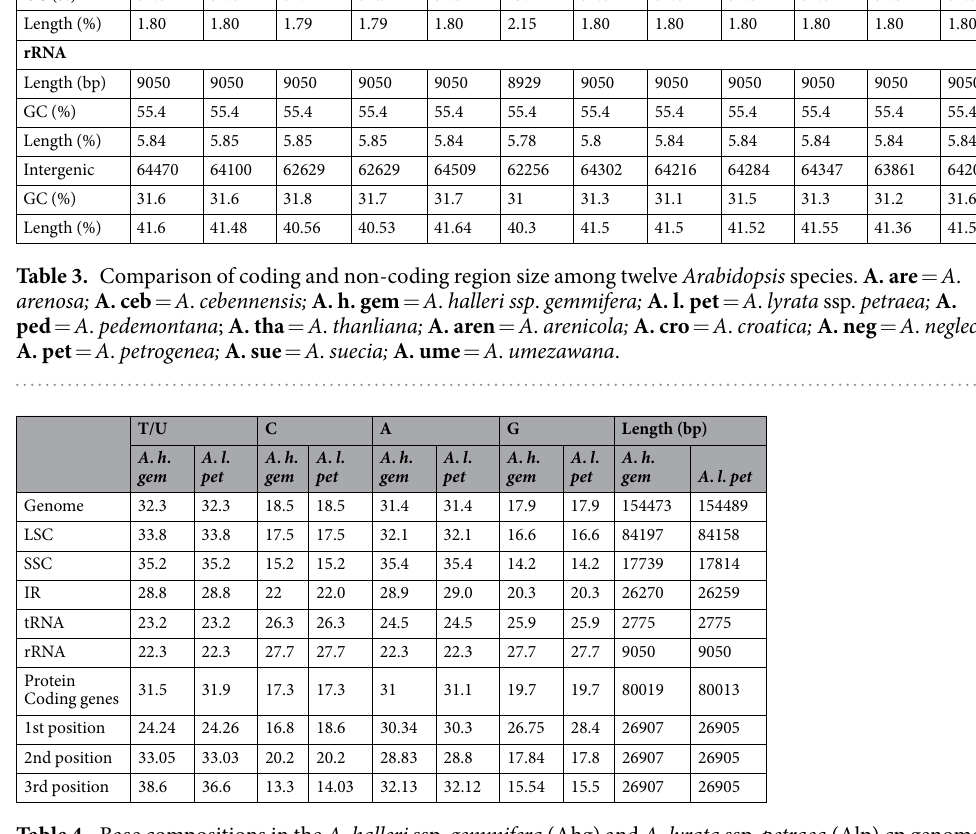
Table 4. Base compositions in the A . halleri ssp. gemmifera (Ahg) and A . lyrata ssp. petraea (Alp) cp genome. A. h. gem = A . halleri ssp . gemmifera; A. l. pet = A . lyrata ssp. petraea